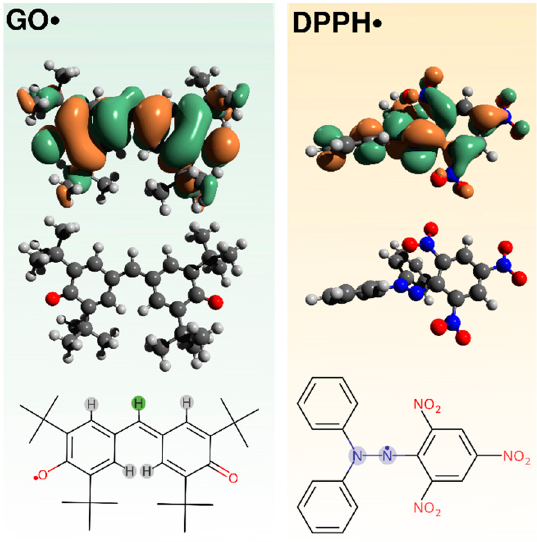
Figure 2. Structure of 2,2-diphenyl-1-picrylhydrazyl (DPPH • ) and galvinoxyl (GO • ) radical along with SOMOs isosurfaces (cutoff isovalue 0.02 e/bohr − 3 ) calculated at the B3LYP/def2-TZVP theory level. Atoms giving rise to the hyperfine splitting observed in the EPR spectra are highlighted.